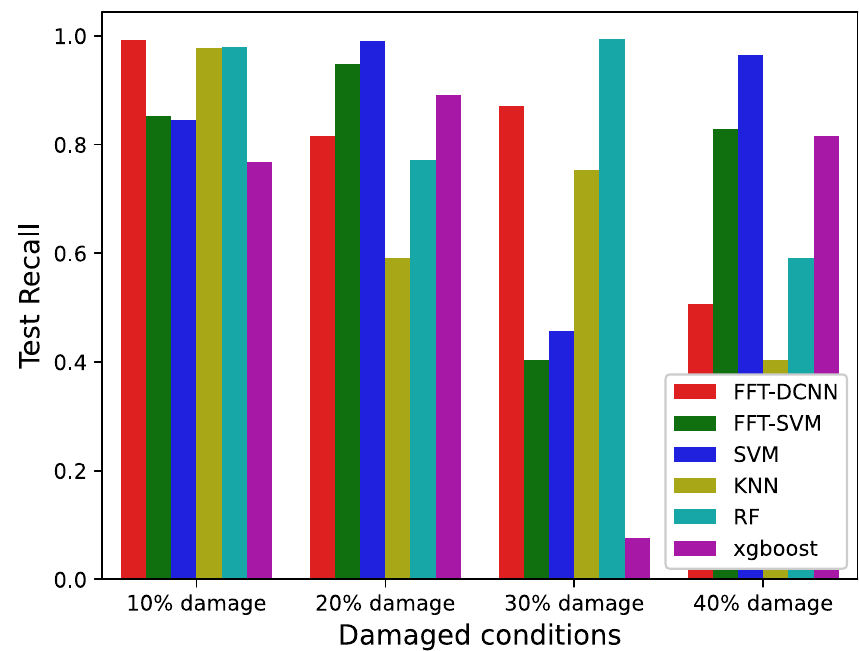
Figure 9. Recall of the test data using different algorithms.